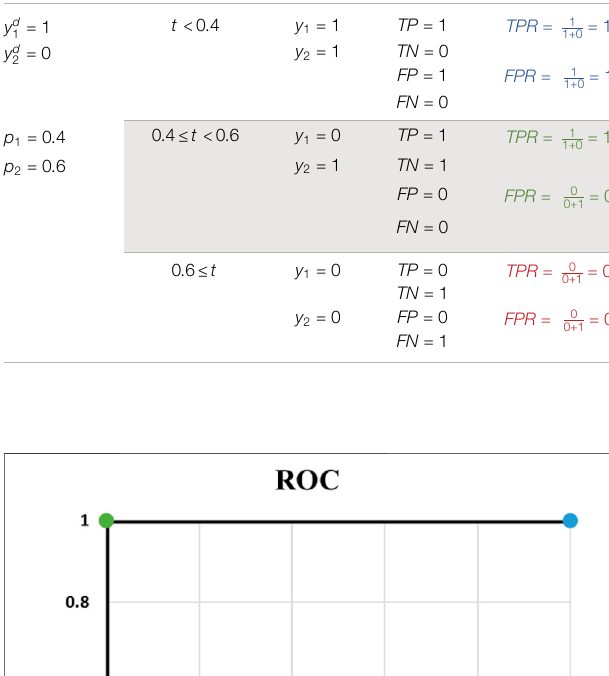
TABLE 4 | Example 3.